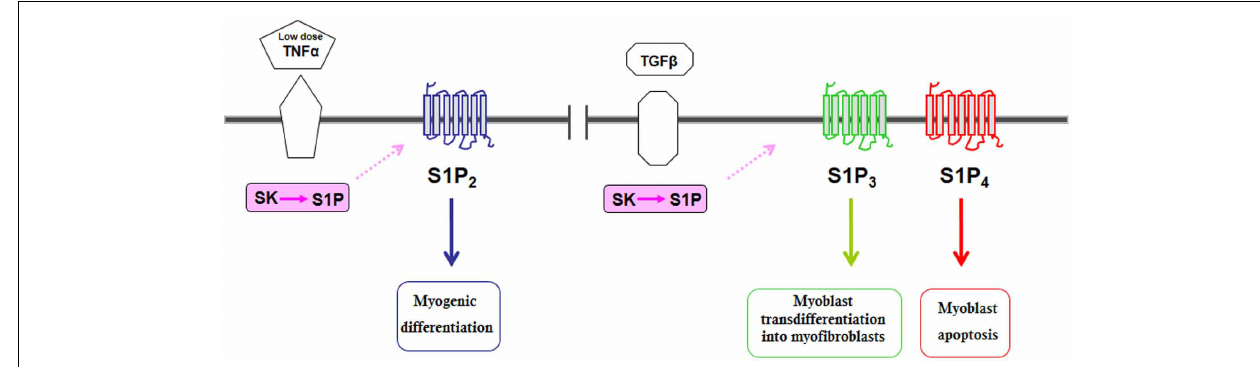
FIGURE 2 | Schematic diagram of the biological actions evoked by S1PR transactivation by some cytokines in C2C12